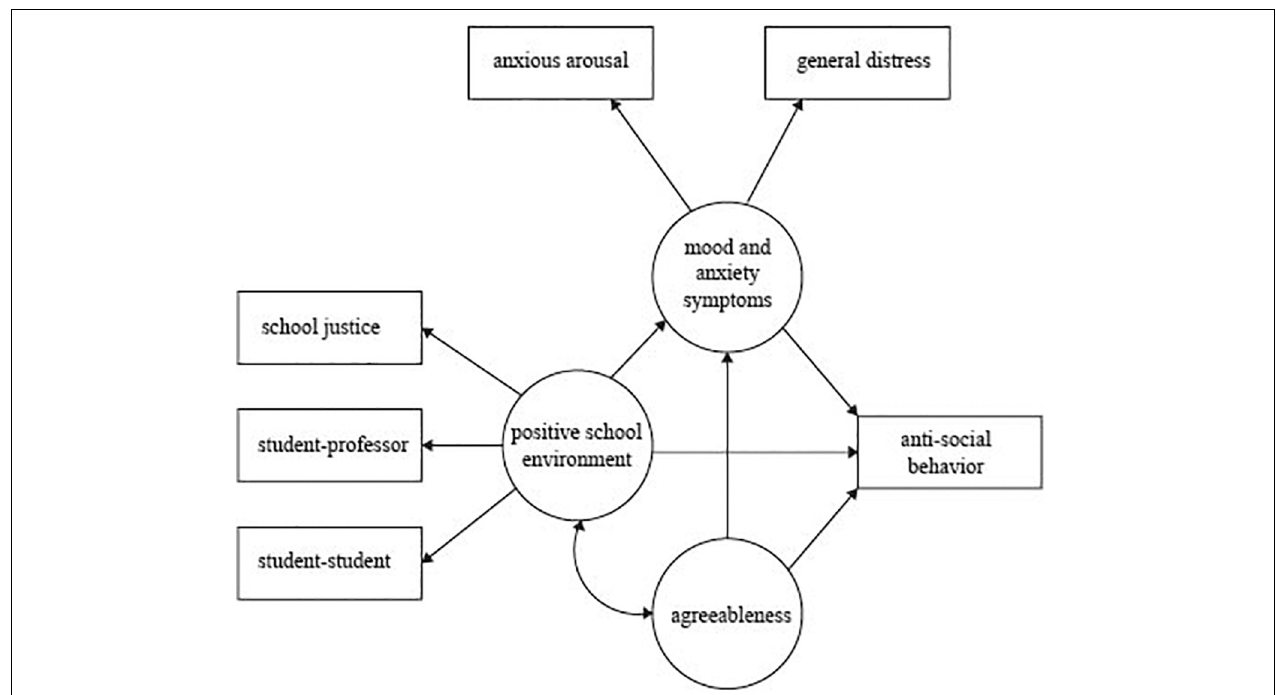
FIGURE 1 | Hypothetical model of positive school environment and agreeableness as protective factors for antisocial behaviors. The model predicts that a positive school environment will have a direct effect on mood and anxiety disorders and antisocial behaviors and indirect effect on antisocial behaviors through mood and anxiety disorders. Agreeableness will have a direct effect on antisocial behaviors and will covary with positive school